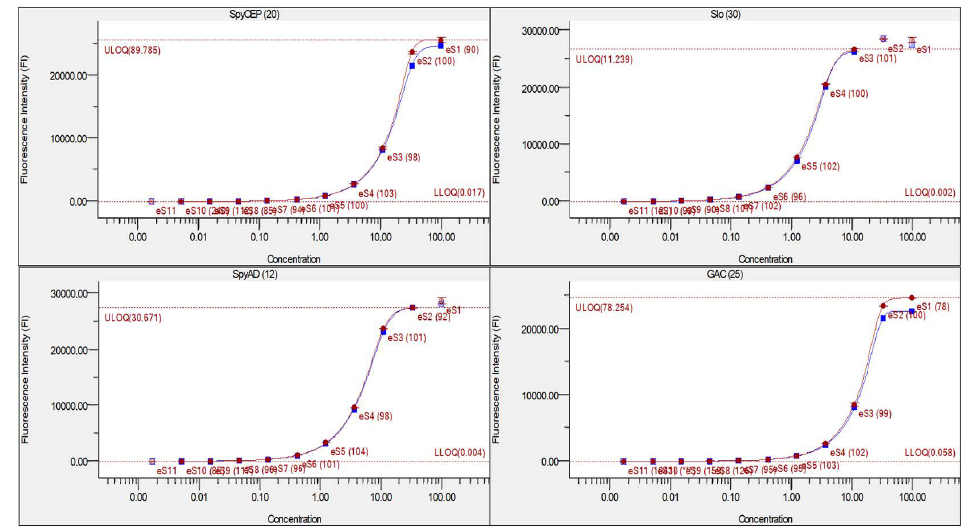
Figure A1. Comparison of Privigen (red) with Octanorm (blue) standard curves fitted with 5-PL regression model. IVIG serially diluted 3-fold from 1:1000 dilution (nominal concentration 100 RLU/mL) to 1: 1:6,561,000. Initial assay conditions were 30 min of primary incubation, 30 min of secondary incubation with 1:70 dilution of secondary antibody.